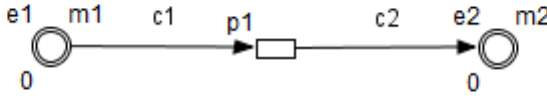
Figure 2. Continuous entities, continuous process and normal connectors.